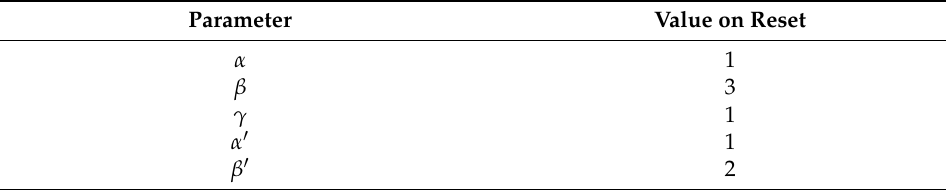
Table 6. Modified Fast TCP parameters.